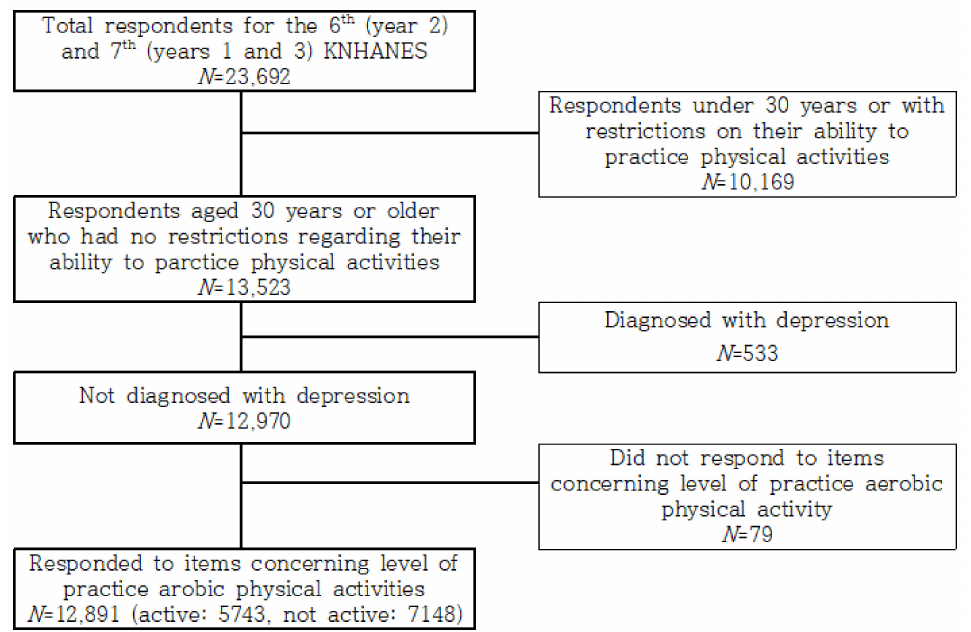
Figure 1. Participant selection